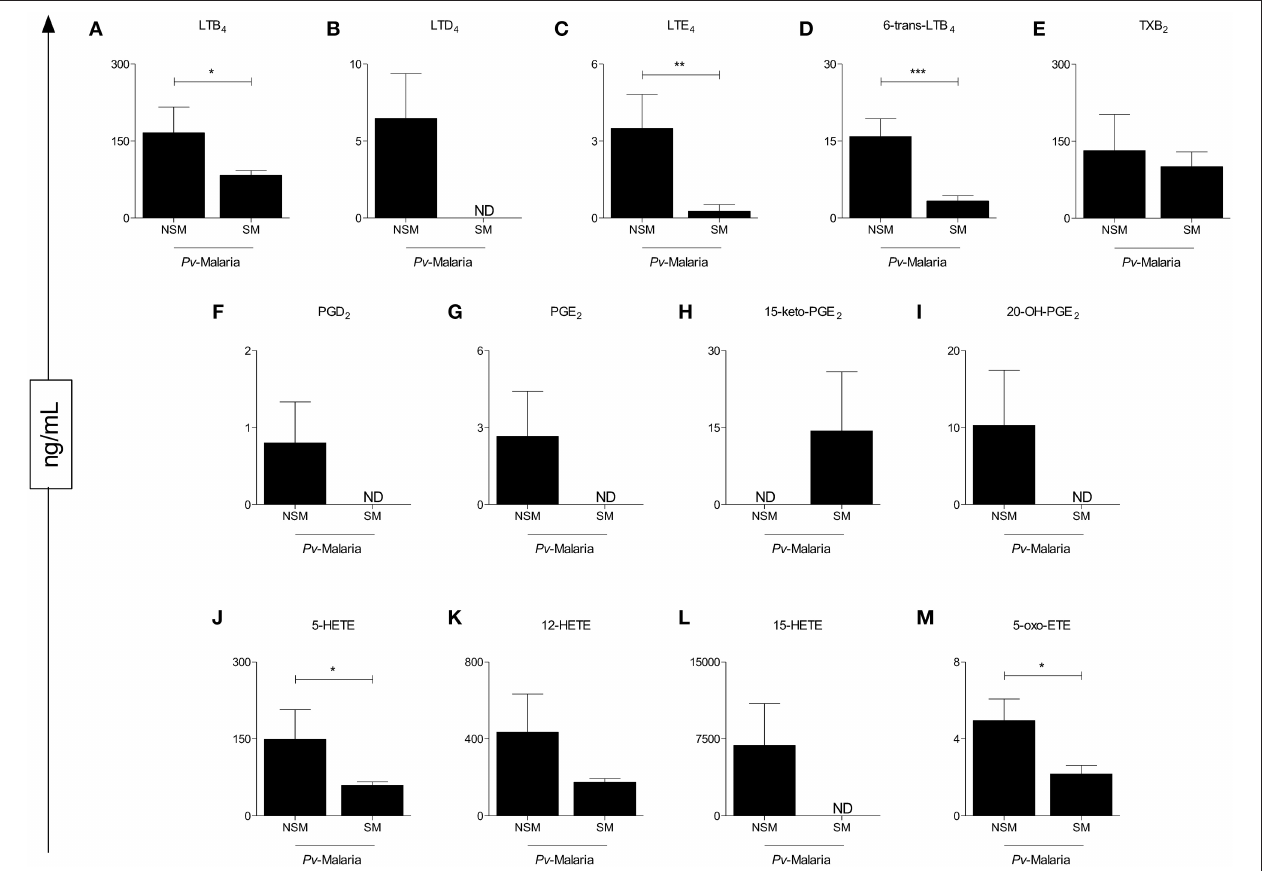
FIGURE 2 | Analysis of the eicosanoid concentrations of Pv -malaria patients at the time of diagnosis who did not Self-Medicate (NSM) and Self-Medicated (SM). * p < 0.05, ** p < 0.01, *** p < 0.0001 between groups studied. ND = Concentration not detected. The quantifications of these lipid mediators were measured using high performance liquid chromatography-mass spectrometry